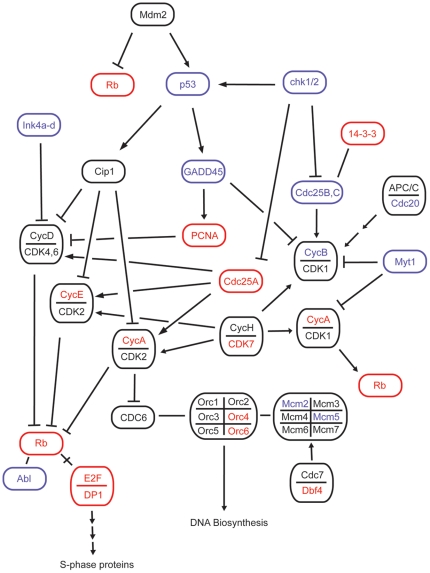
Cell cycle genes regulated by PAR2 (red, up-regulated; blue, down-regulated; black, other related genes).Among key cell cycle components modulated were p53, the cyclin family, and the cdk family. The influence on cell cycle progression is not clear despite reports of PAR2 in cell proliferation.